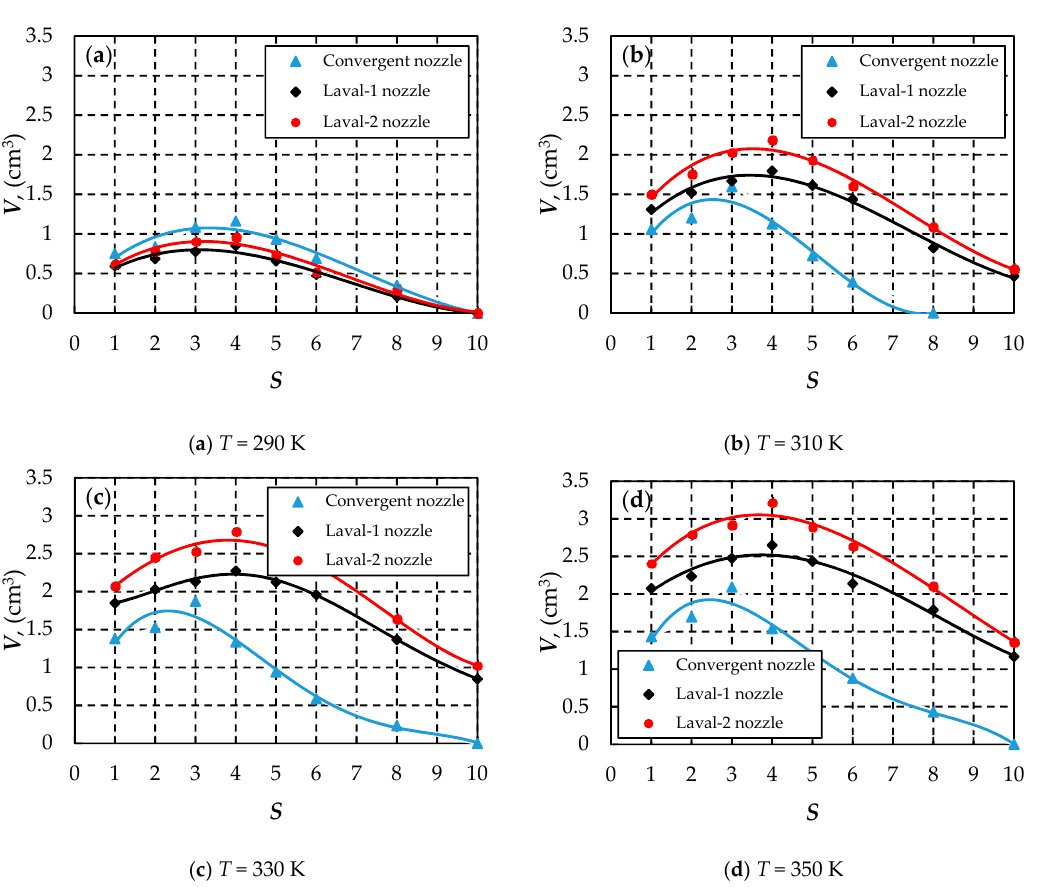
Figure 9. Effect of nozzle configuration on rock erosion volume of the SC-CO 2 jet under different fluid temperatures.